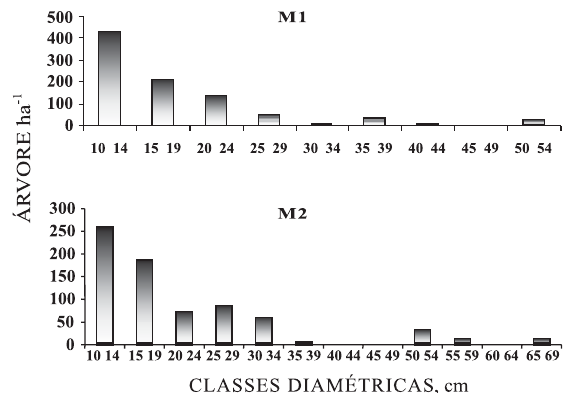
Figura 1. Distribuição do número de árvores por hectare e por classe diamétrica de indivíduos com DAP maior do que 10 cm em fragmentos florestais (M1 e M2) da Mata Atlântica, na região